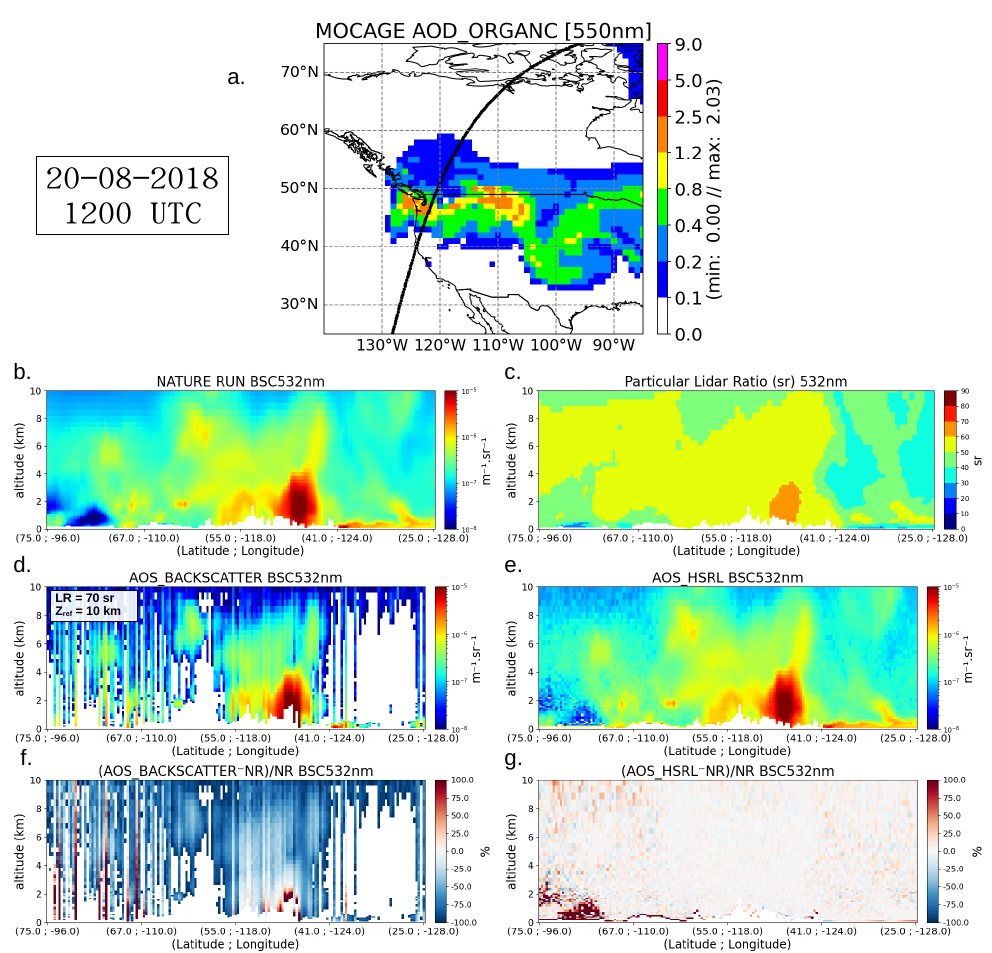
Figure 8. Case from 20 August 2018 at 1200 UTC. ( a ) AOD of organic carbon from the NR together with the studied satellite trajectory (black line). ( b ) Particular backscatter profile transects of biomass burning along the satellite trajectory in the NR. ( c ) Corresponding particular lidar ratio transect calculated from the NR. ( d , e ) Simulation of the backscatter coefficient SO for the AOS_Backscatter and the AOS_HSRL configurations. ( f , g ) Relative mean bias (SO-NR)/NR of both